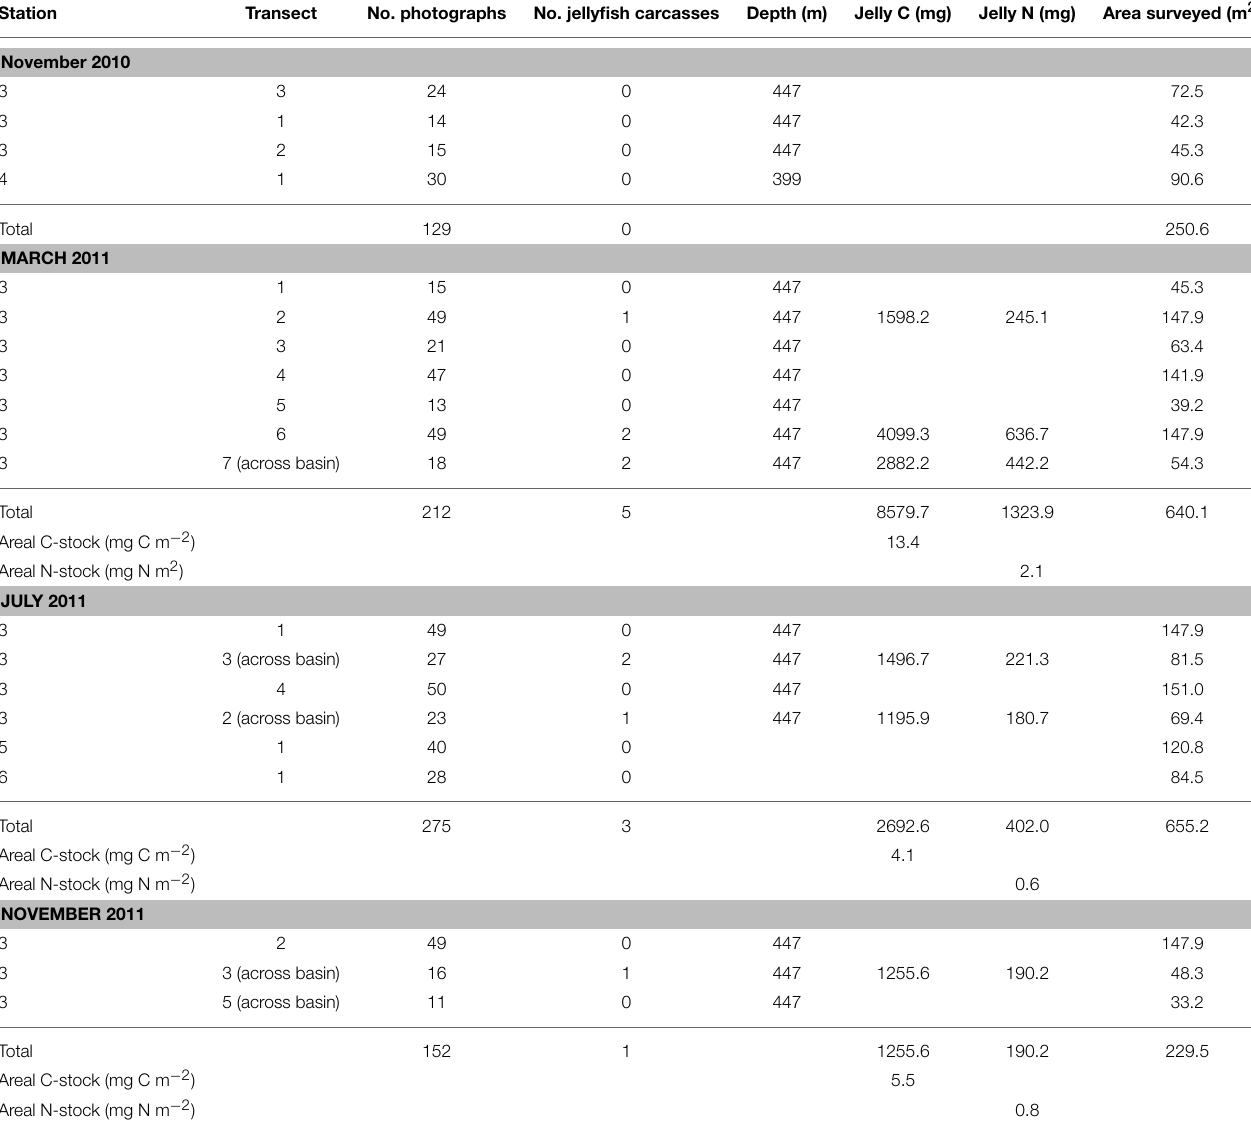
TABLE 1 | The number of jelly-falls documented at the seafloor, their contribution to seafloor C and N stocks, and the area photographed at different times of year. Station